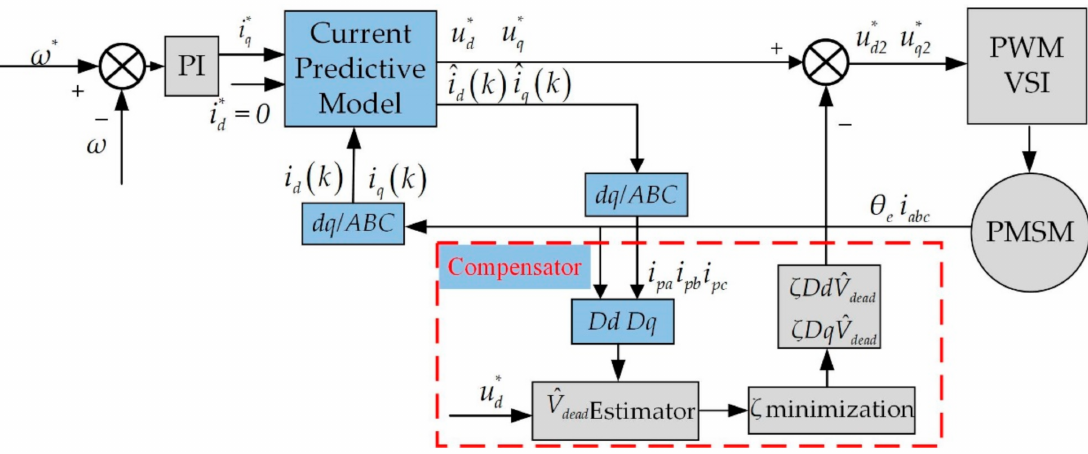
Figure 7. VSI nonlinearity compensation for current predictive control of PMSM with proposed